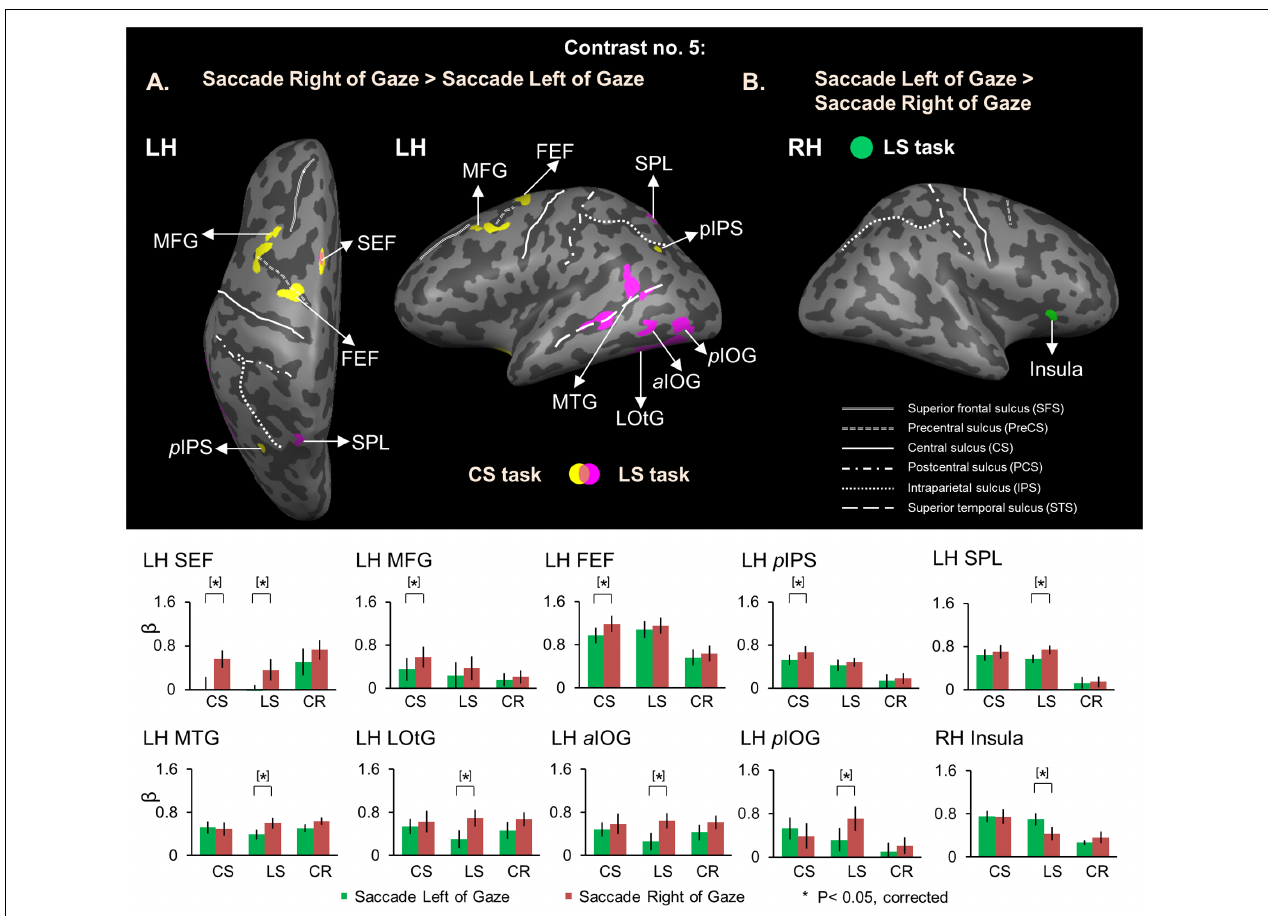
FIGURE 9 | Voxelwise activation maps obtained with RFX GLM and activation levels for each area using Contrast no. 5 during the Response phase. Top panel: activation maps rendered on the inflated brain of one representative participant. (A) Saccade Right of Gaze > Saccade Left of Gaze. Yellow, voxels activated in the CS task. Pink, voxels activated in the LS task. Orange, voxels activated in both tasks. (B) Saccade Left of Gaze > Saccade Right of Gaze. Green, voxels activated in the LS task. Bottom panel: bar graphs show the β weights for each condition in each area. Legends as in Figure 2 . FEF and SEF correspond to anatomic areas, the intersection between precentral sulcus and superior frontal sulcus (FEF), and the medial surface of the superior frontal gyrus (SEF), respectively. Note that to be consistent with previous saccade neuroimaging literature, we have provided functional rather than anatomic names for these structures, based on previously published coordinates (Luna et al., 1998; Cornelissen et al., 2002; Connolly et al.,